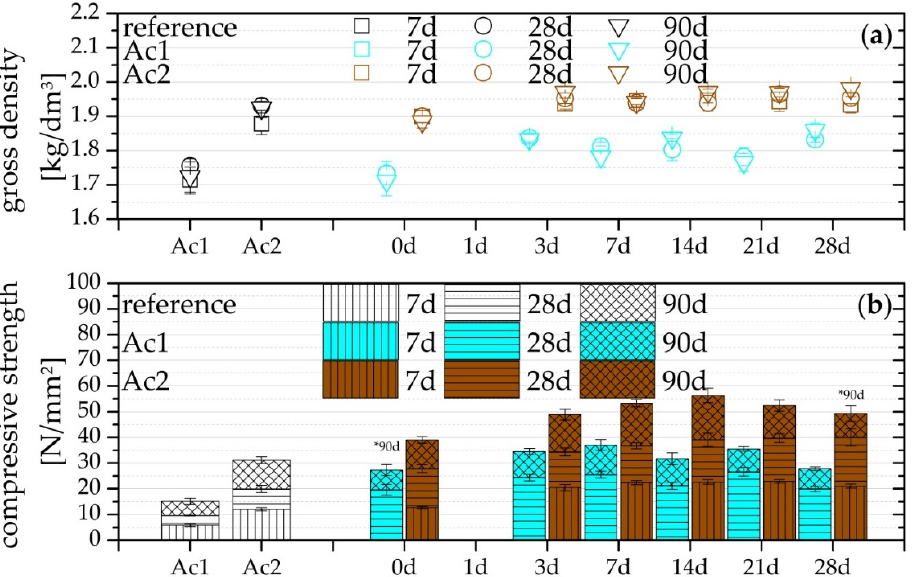
Figure 3. ( a ) Gross density and ( b ) compressive strength after seven, 28 and 90 days of hydration, of the reference (without retarder) and the reactivated mixtures with NaOH after seven different periods of retardation with